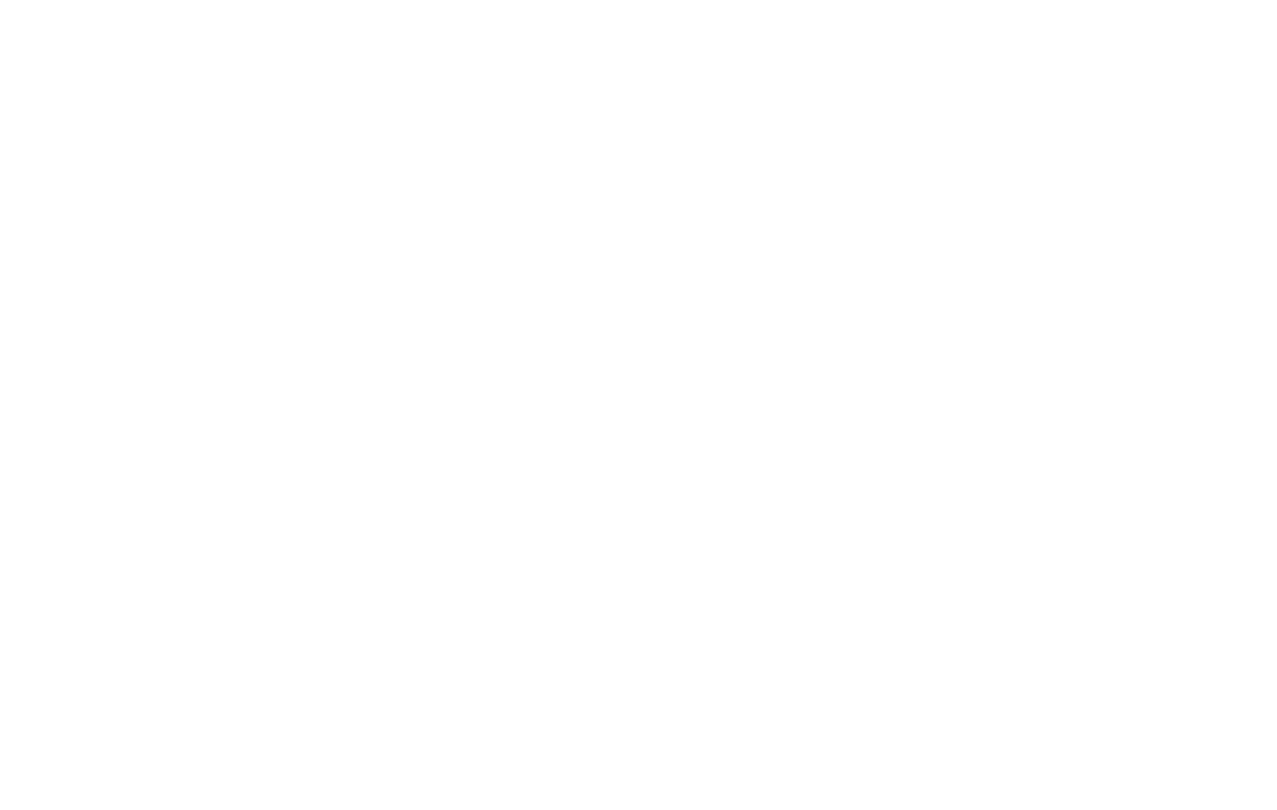
Frontiers in Forests and Global Change |